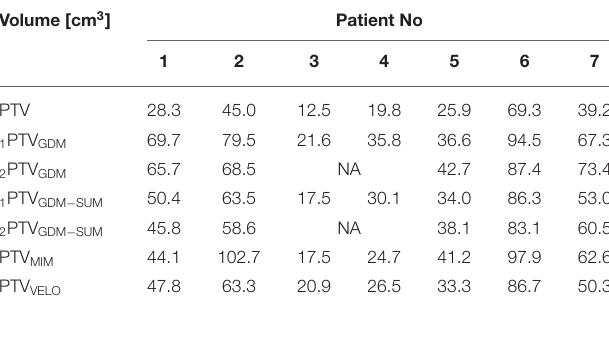
TABLE 3 | Absolute volumes indicated by TPS for each constructed structure for 7 patients. Volume [cm 3 ]